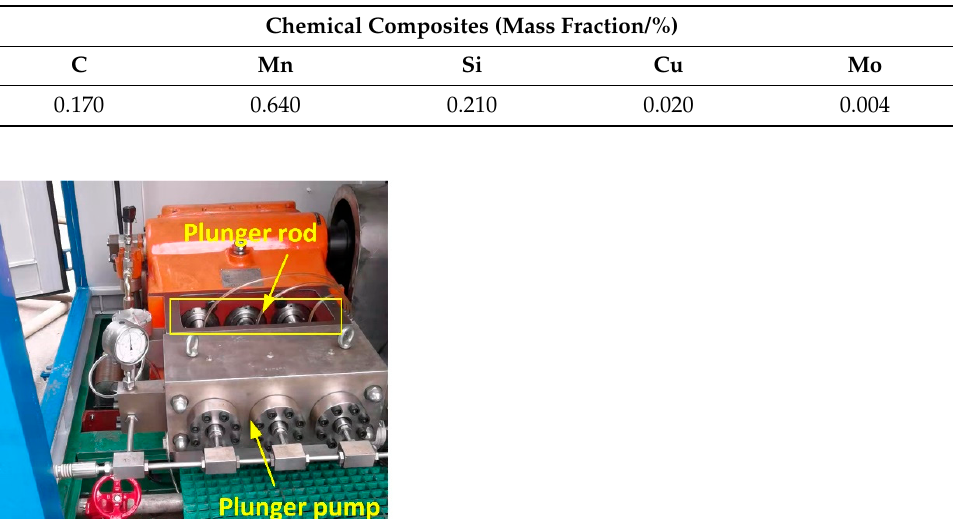
Table 1. Chemical composition of Grade A marine steel.